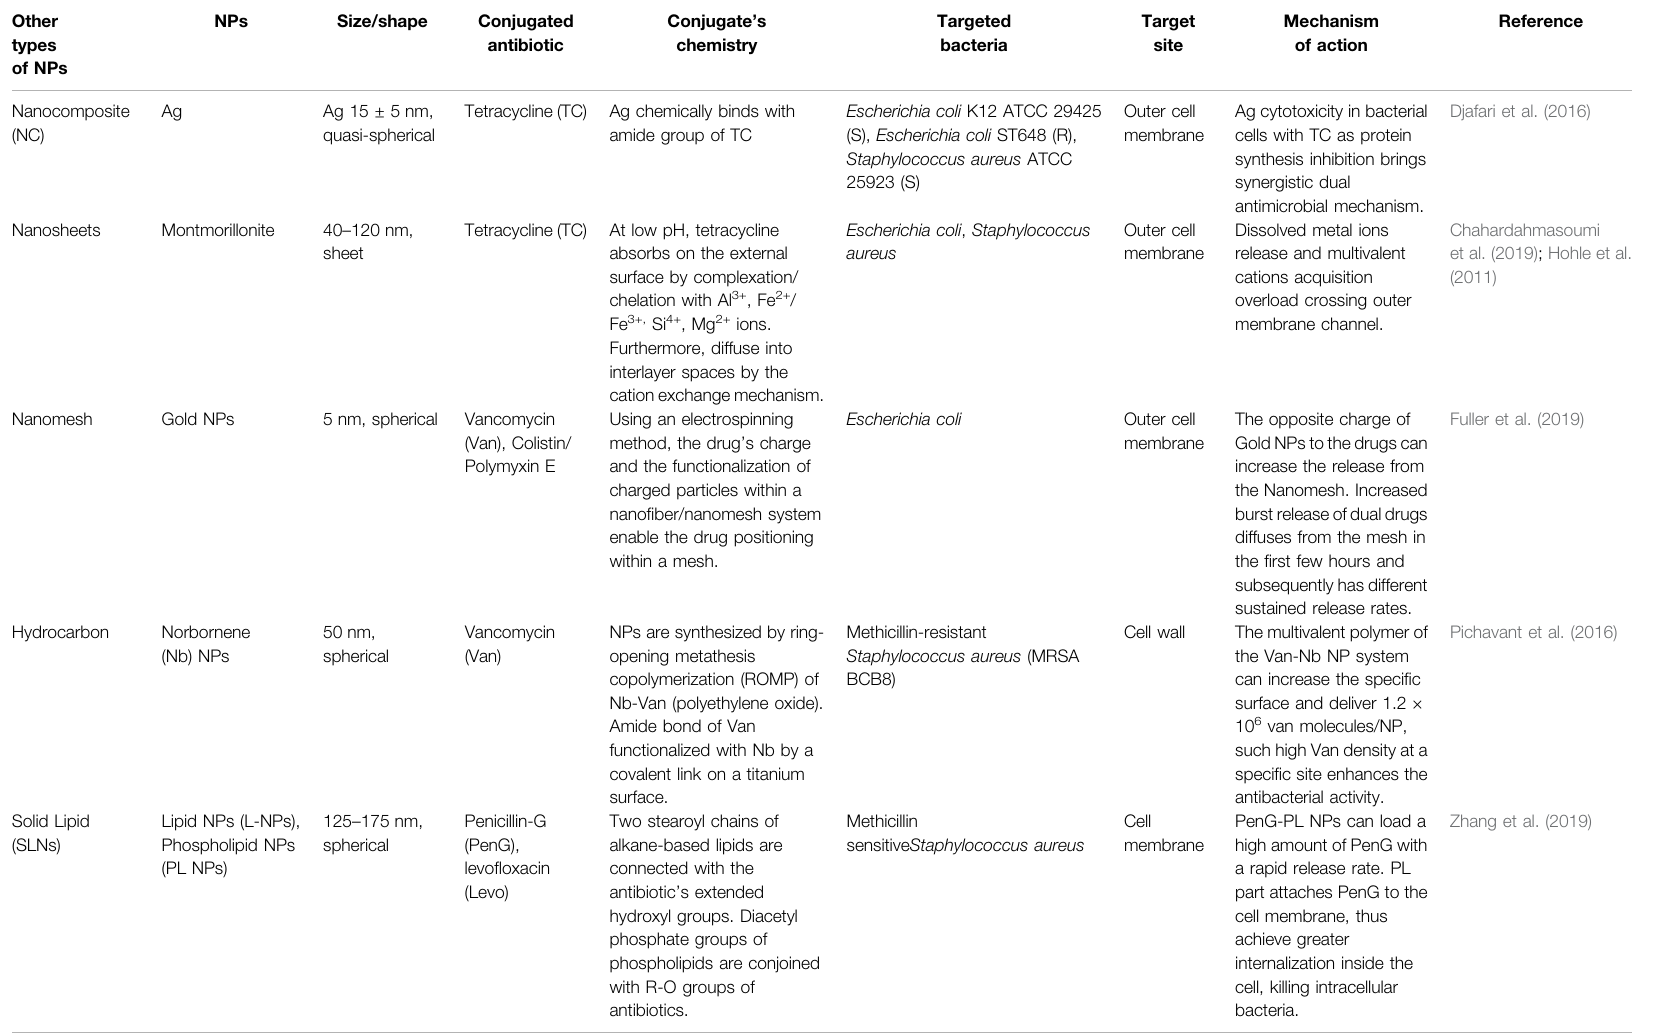
TABLE 8 | Other types of nAbts and their associated